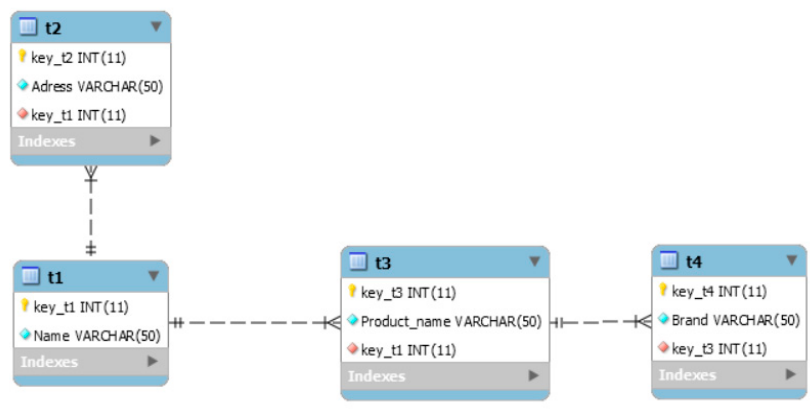
Figure 11. An example of a database of four tables.